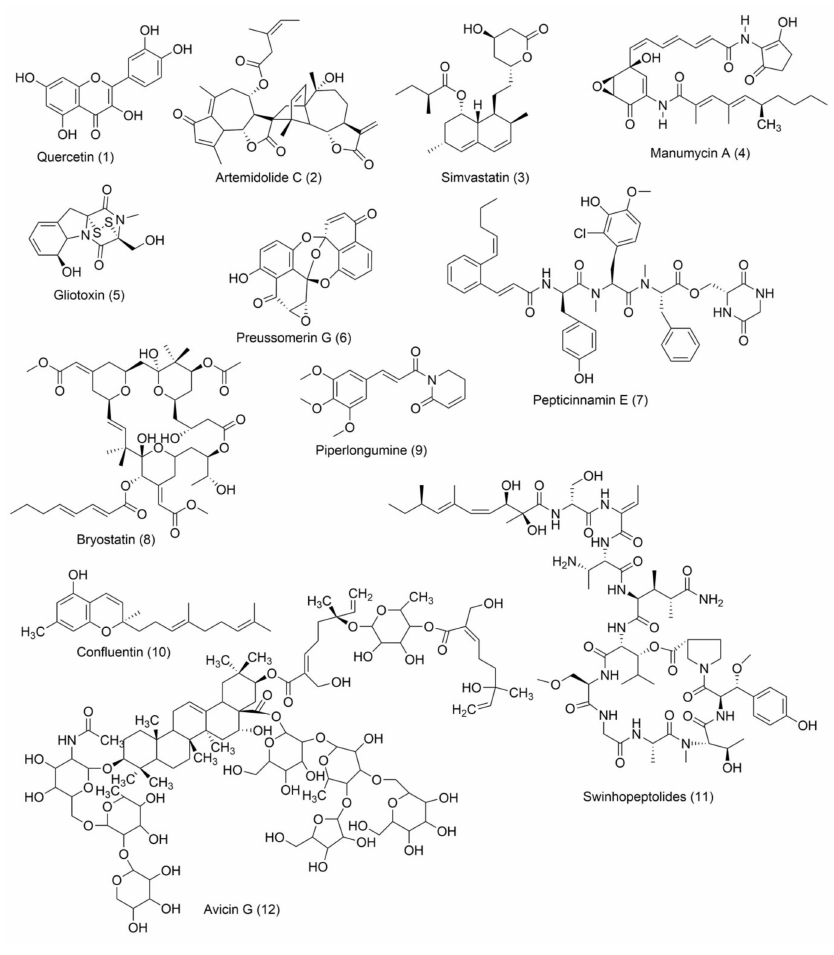
Figure 3. Heterocyclic natural product RAS